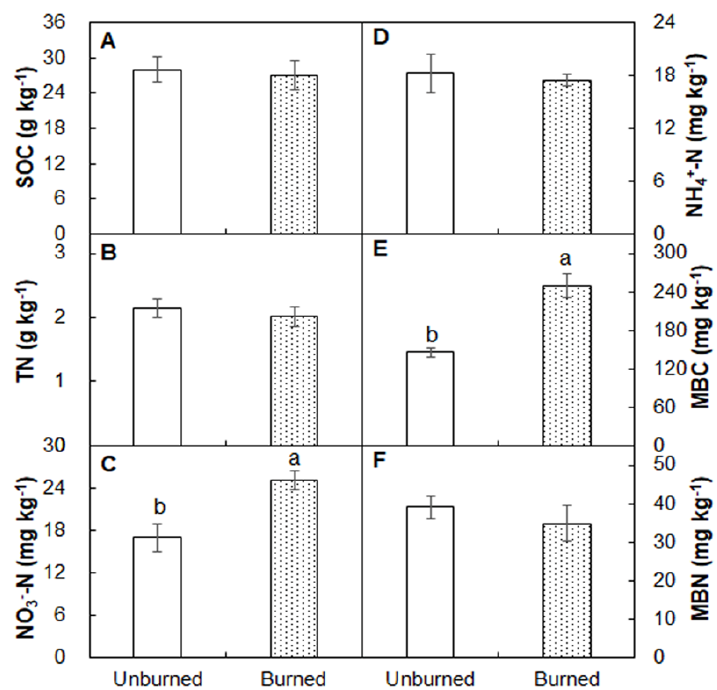
Figure 2. Differences in soil organic C (SOC, A ), total N (TN, B ), NO 3- -N ( C ), NH 4+ -N ( D ), microbial biomass C (MBC, E ), and microbial biomass N (MBN, F ) between the unburned and burned plots. Different letters indicate significant differences between treatments at p < 0.05. Values are presented as the means ± standard error.